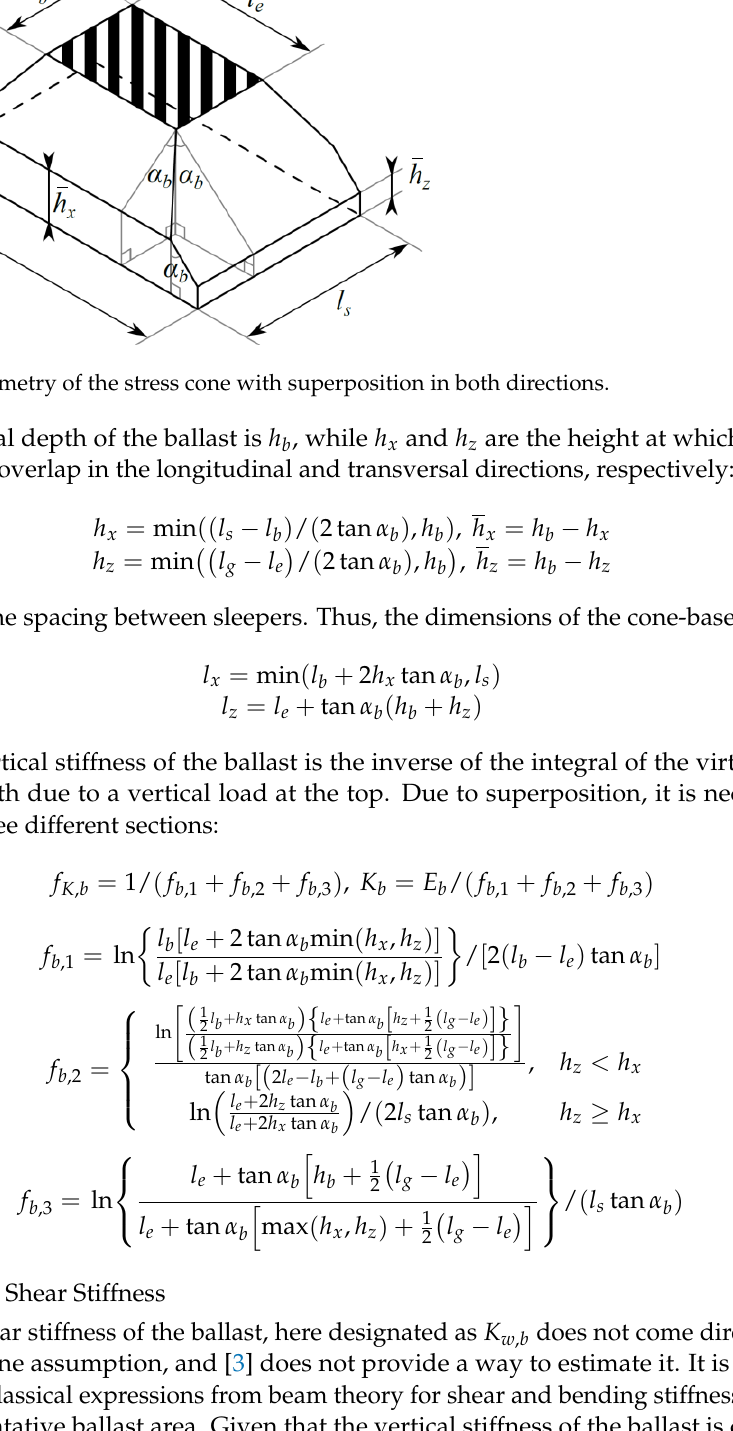
Figure 8. Superposition of the stress cones in the transversal direction.